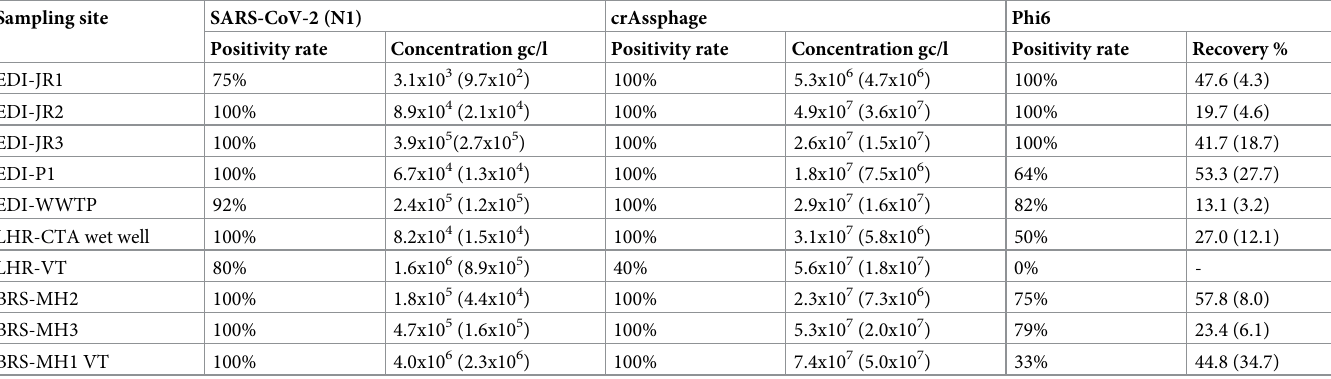
Table 5. SARS-CoV-2 and crAssphage detection rates and concentrations along with Phi6 process control recoveries for airport wastewater surveillance. Sampling